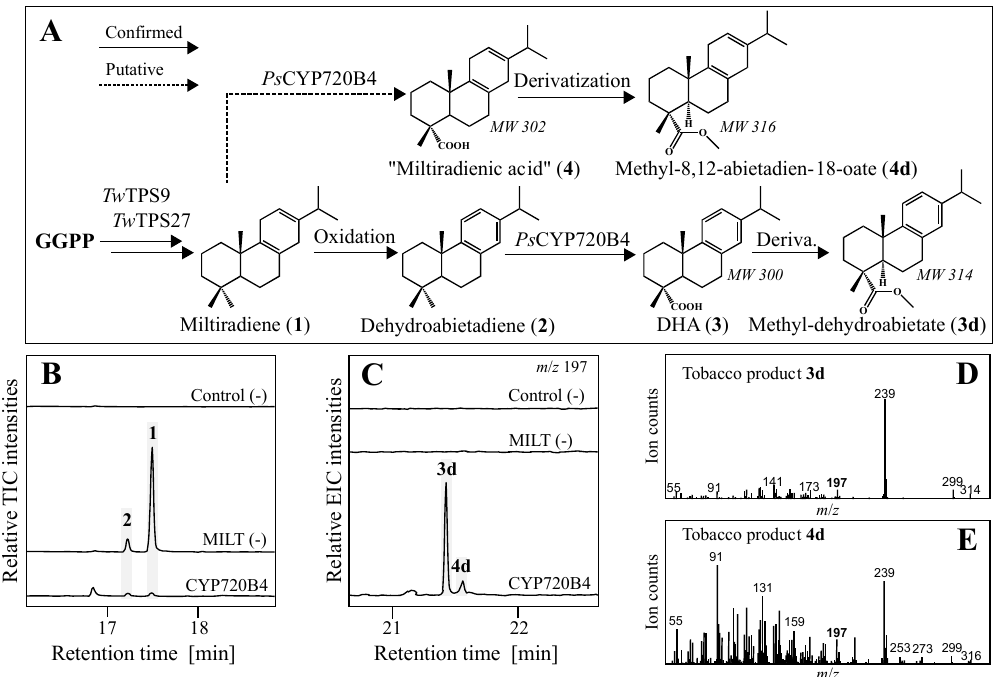
Figure 2. Identification of a dehydroabietic acid ( 3 ) pathway by transient expression in tobacco. ( A ) Transiently expressed genes with confirmed and putative diterpene products detected after derivatization; MW, molecular weight, corresponding to m / z for 4d and 3d ; ( B ) Total ion chromatograms (TIC) of control plants without diTPS, plants expressing Tw TPS9 and Tw TPS27 (MILT (-)) and the addition of Ps CYP720B4; ( C ) Extracted ion chromatograms (EIC) of m / z 197, characteristic for both diterpene products, showing novel peaks 3d and 4d when Ps CYP720B4 was expressed in combination with diTPSs; ( D ) MS spectra of 3d corresponding to derivatized methyl-ester of 3 ; ( E ) MS spectra of 4d corresponding to putative methyl-ester of miltiradienic acid ( 4 ).